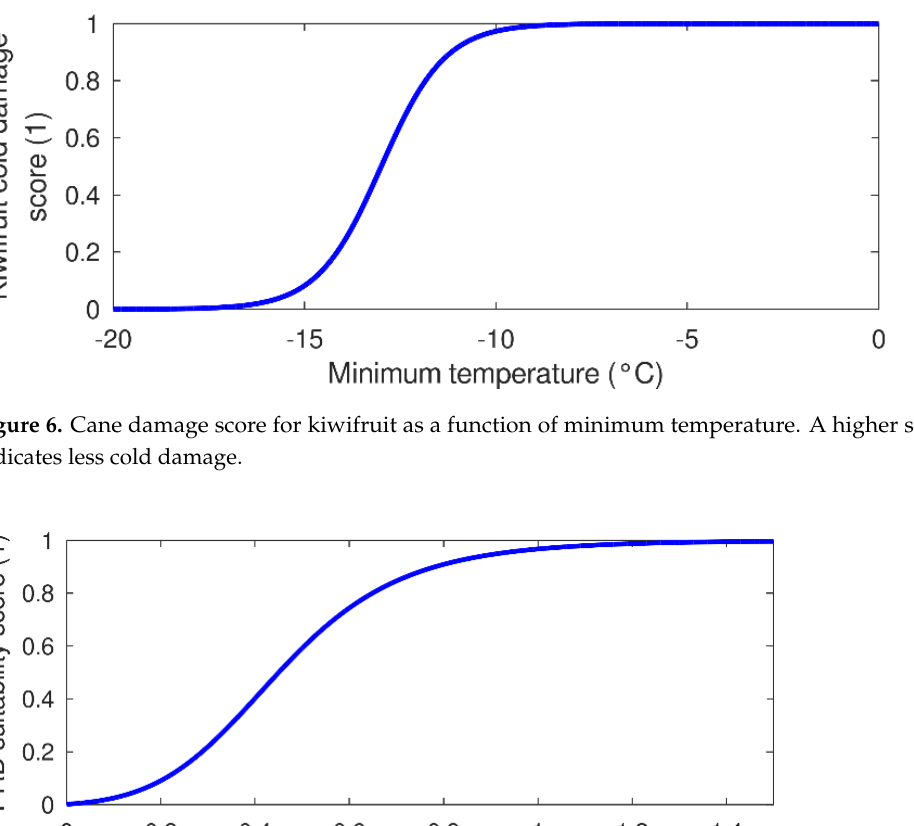
Figure 6 . Cane damage score for kiwifruit as a function of minimum temperature. A higher score indicates less cold damage.